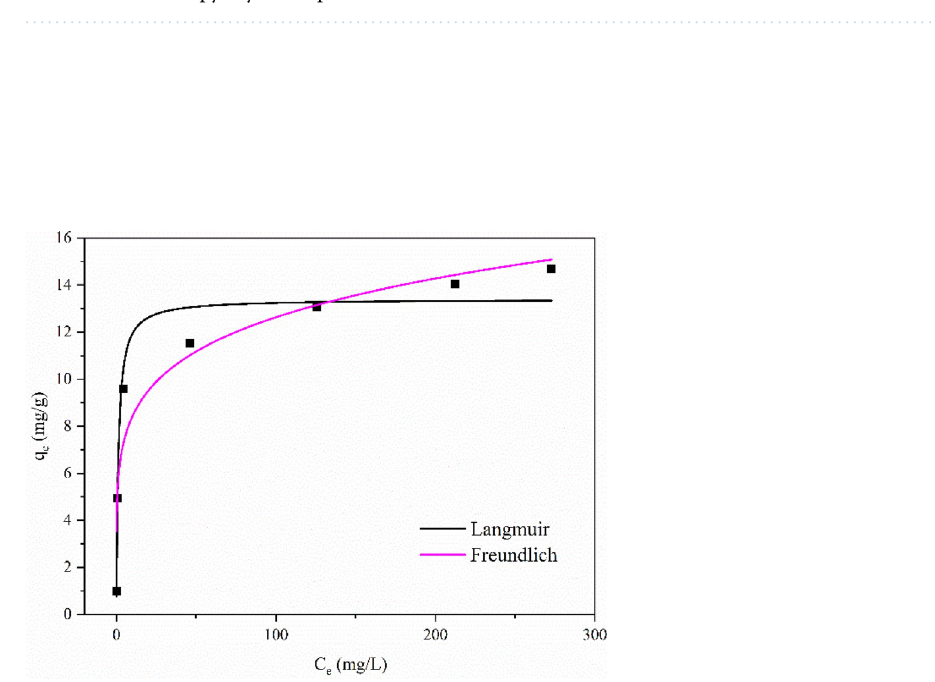
Figure 8. XRD images: ( a ) before and after adsorption of Cd 2+ on C16 biochar and ( b ) Cd 2+ adsorption by biochar at different pyrolysis temperatures.